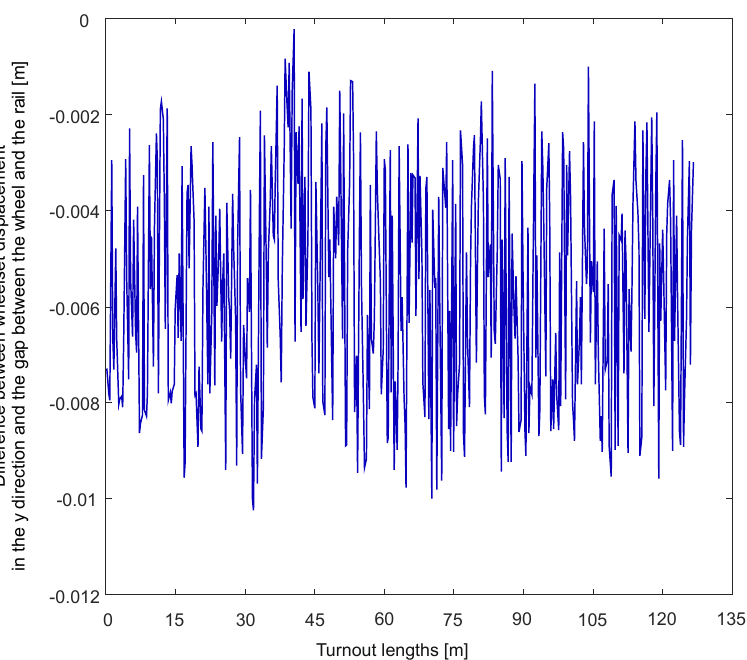
Figure 14. The difference between displacement and a gap for a train crossing the turnout along a